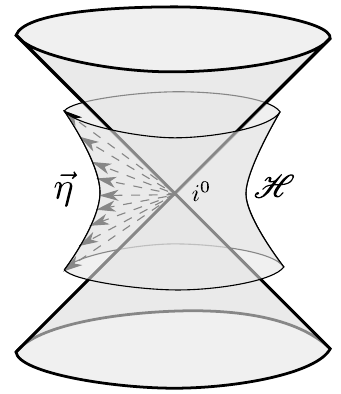
Figure 1 . The (non-compact) unit-hyperboloid H in Ti 0 representing spatial directions ~η at i 0 . At spatial infinity represented by a single point i 0 in M , the gravitational fields of interest, in general, only admit direction-dependent limits, and hence it is rather awkward to study such fields directly at i 0 . Instead of working at the point i 0 one works on the space of directions at i 0 i.e., a blowup of i 0 (see [38]). The fields which have regular